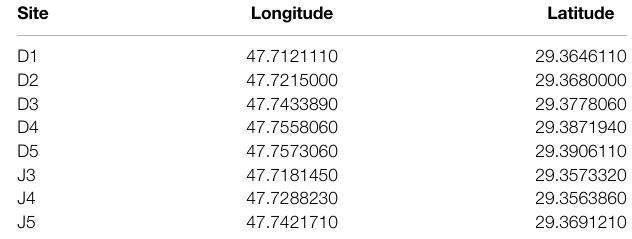
TABLE 1 | Locations of the sampling